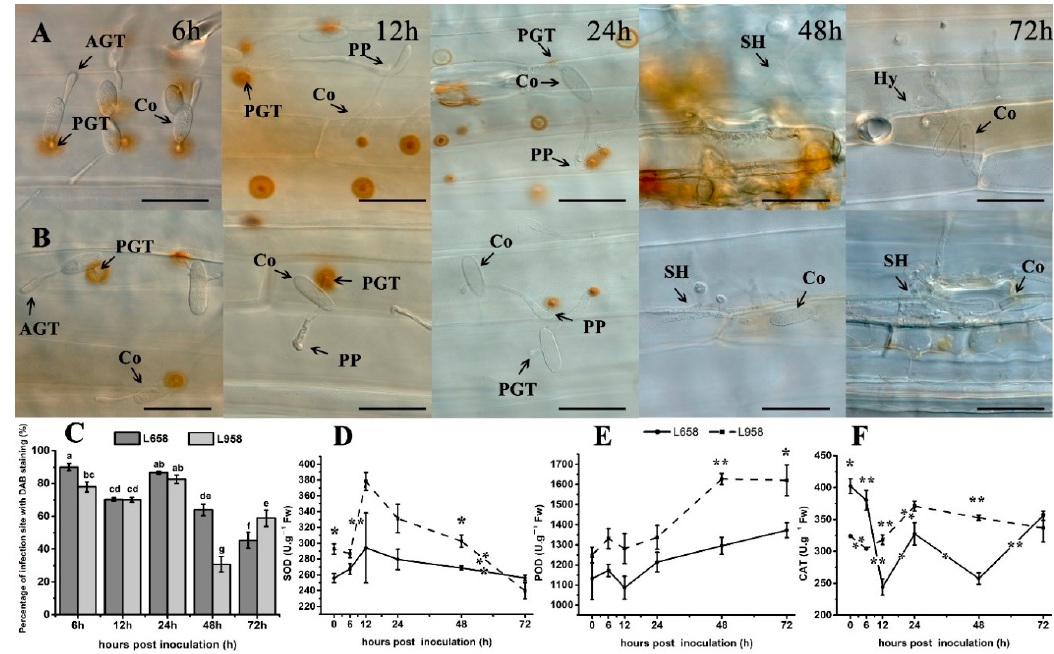
Figure 2. H 2 O 2 accumulation revealed by 3’-diaminobenzidine (DAB) staining at interaction sites in the resistant wheat line L658 and susceptible wheat line L958 after inoculation with Bgt and activity of antioxidant enzymes at various time points. H 2 O 2 accumulation (reddish-brown) staining by DAB at interaction sites in L658 ( A ) and L958 ( B ) at various time points. AGT: appressorium germ tube; PGT, primary germ tube; PP: penetration peg; SH: secondary hyphae; Hy, hyphae; Co: conidia. The dark bar indicates 50 μ m. ( C ) Dark grey and light grey bars represent the percentage of infection sites exhibiting H 2 O 2 accumulation in L658 and L958, respectively, after inoculation with Bgt at various time points. Each point represents at least 100 infection sites of each of three leaf pieces, and the lowercase letter at the top of the bar chart represents statistically significant differences at p < 0.05. Activities of SOD ( D ), POD ( E ), and CAT ( F ) at different inoculation time points in the two genotypes; the solid and dotted lines represent L658 and L958, respectively. The vertical bars represent the means ± SEs. The asterisks represent significant differences as follows: ** p < 0.01 and * p < 0.05. The asterisk at the top of the line chart represents the difference between L658 and L958 at each time point. The asterisk on the trend line represents the difference between two adjacent time points for the same genotype.